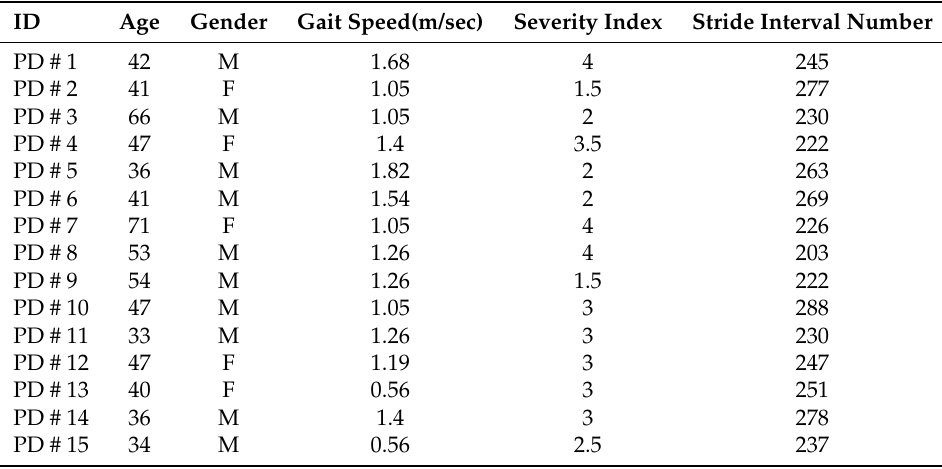
Table 4. The subjects’ clinical information of the Parkinson’s disease (PD)